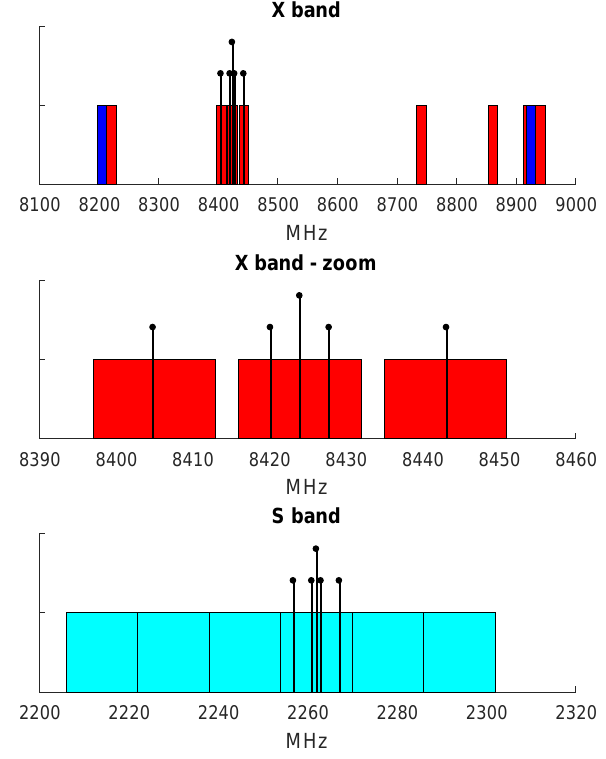
Figure 3. APOD signal and recording channel allocation in the frequency domain. The 16 MHz recording channels are illustrated by red (X-band, upper side band), blue (X-band, lower side band), and cyan (S-band, upper side band) boxes. The APOD tones are indicated as black lines with the carrier having a larger amplitude than the surrounding DOR tones. The X-band signals span over 38.3 MHz and were recorded in three 16 MHz channels (upper and middle panels). The S-band tones are covered by one 16 MHz channel centered at the carrier (bottom